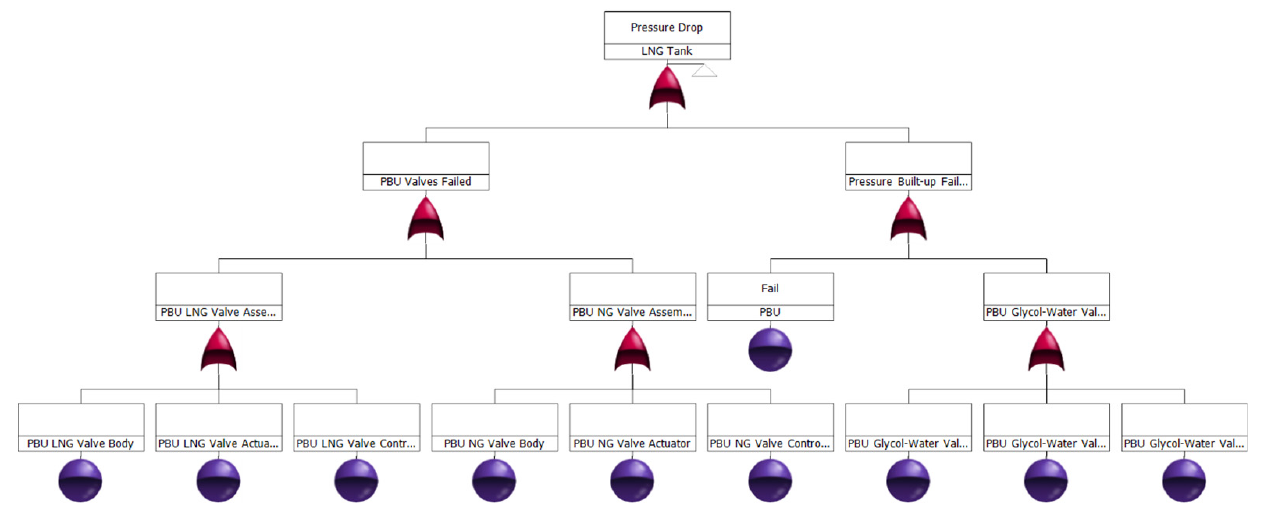
Figure A2. Fault tree for the top event of the tank pressure drop developed in PTC Windchill.